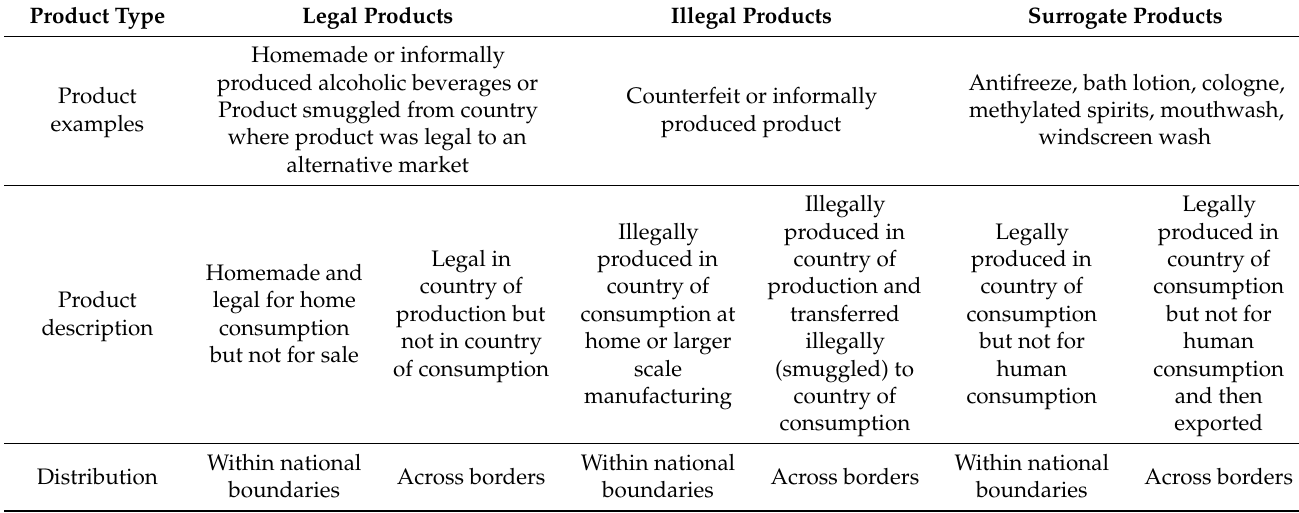
Table 2. Typology of illicit (unrecorded, unreported) alcohol production (Adapted from [62–64]). Product